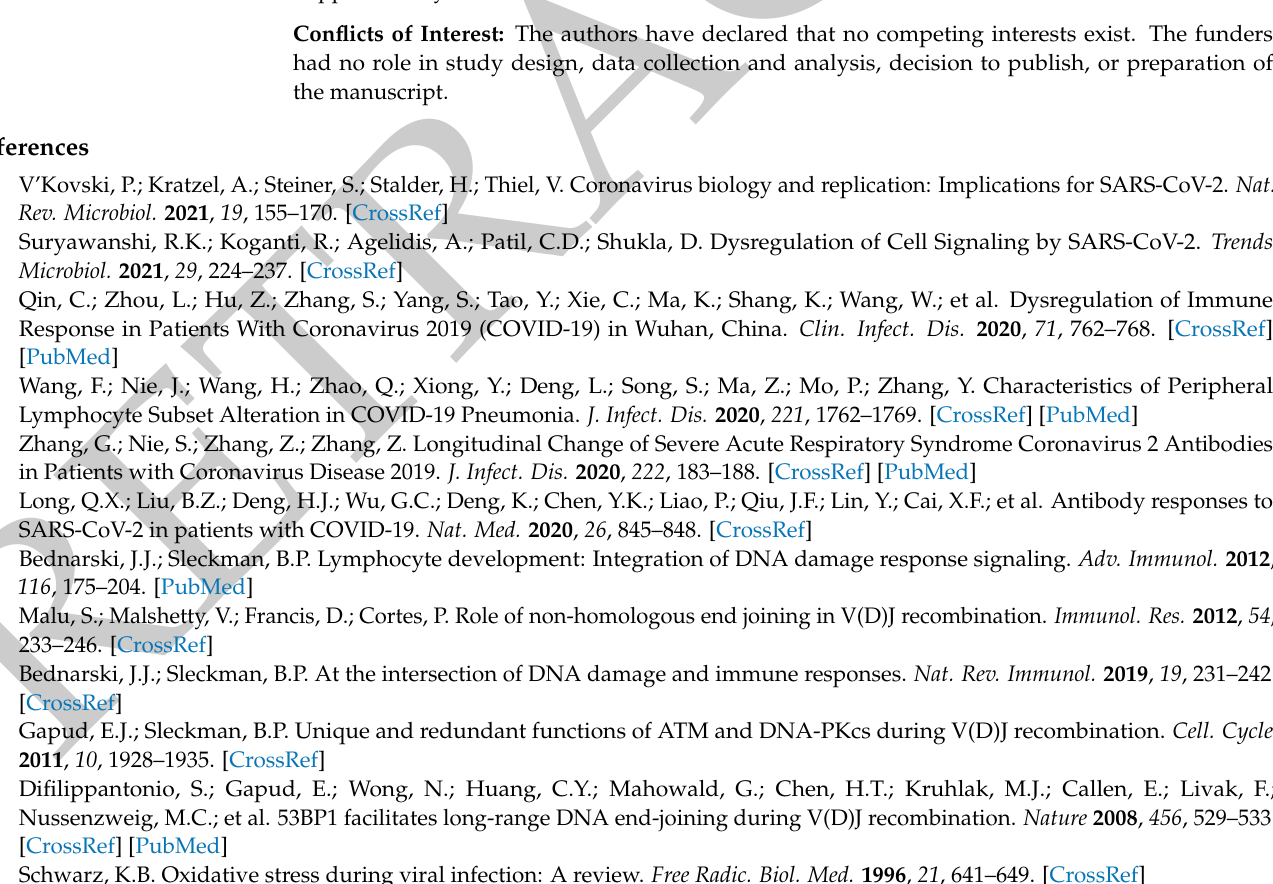
cells, Figure S2: Effect of nuclear SARS–CoV–2 proteins on NHEJ– and HR–DNA repair pathway, Figure S3: Nsp1, Nsp5, Nsp13, Nsp14 but not spike inhibit cell proliferation, Figure S4: Effect of SARS–CoV–2 spike mutants on NHEJ– and HR– DNA repair pathway, Figure S5: In vitro